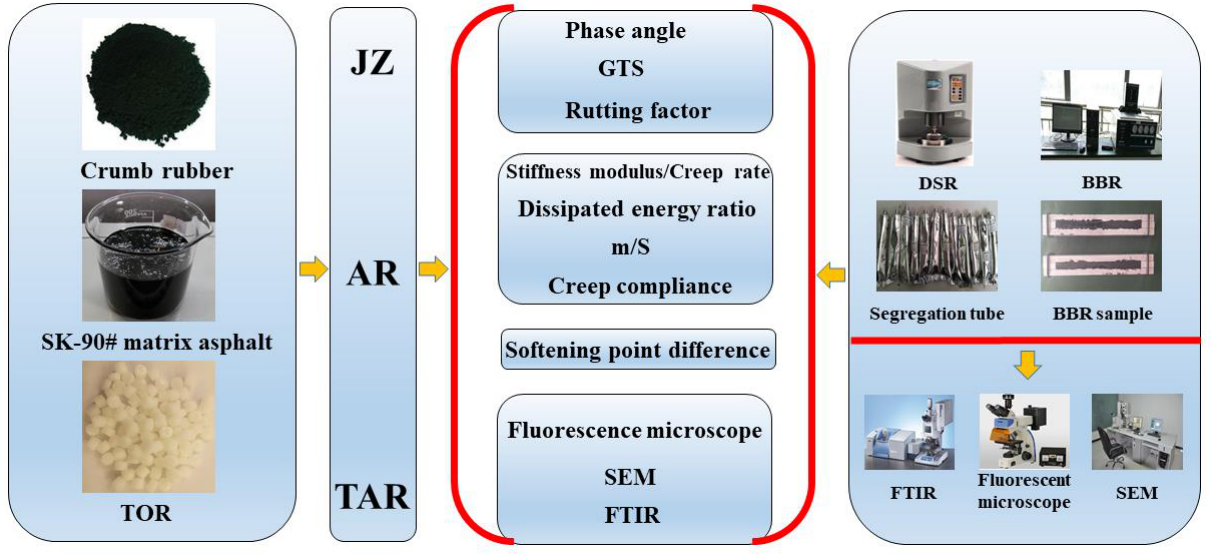
Figure 10. Flow chart of material preparations and experimental programs.